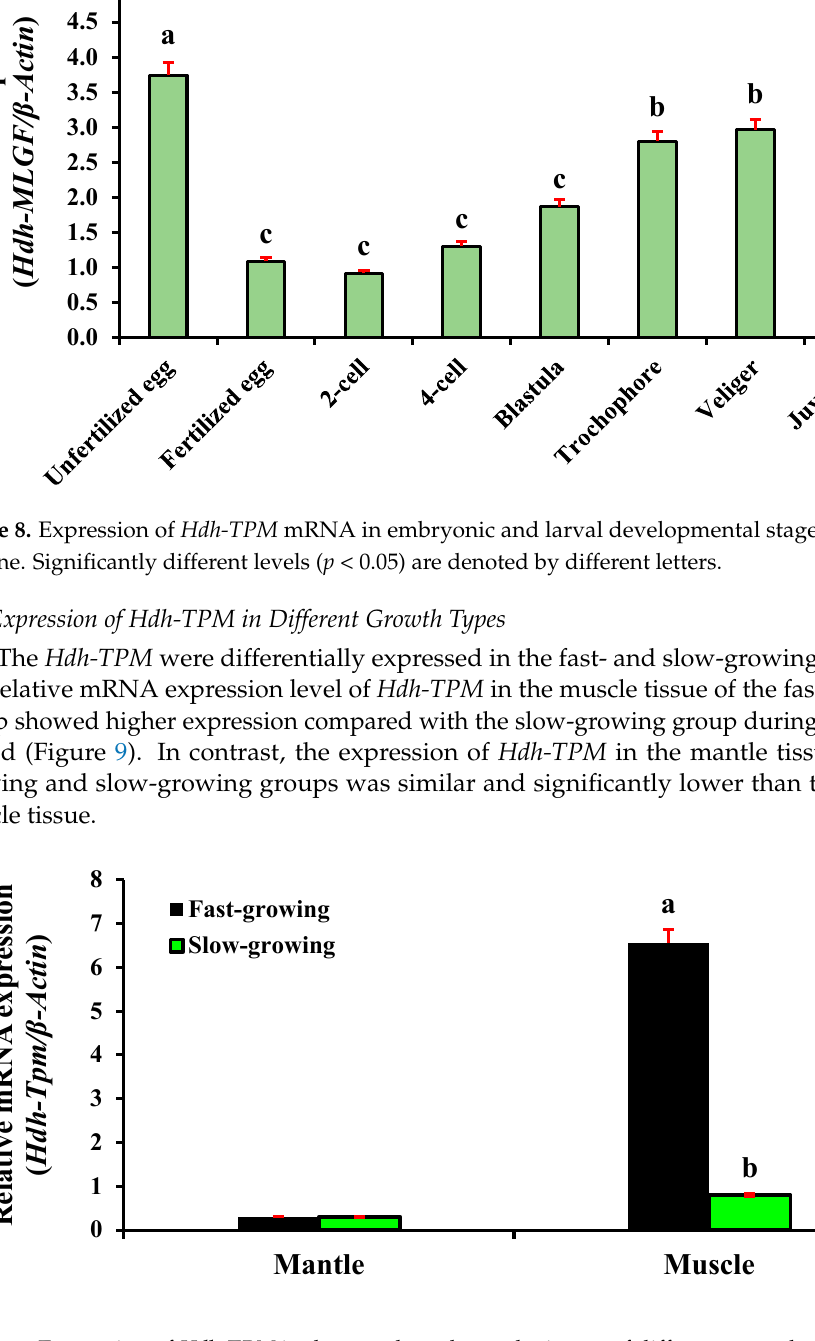
Figure 9. Expression of Hdh-TPM in the mantle and muscle tissues of different-growth-type Pacific abalones, H. discus hannai . Significantly different levels ( p < 0.05) are denoted by different letters.